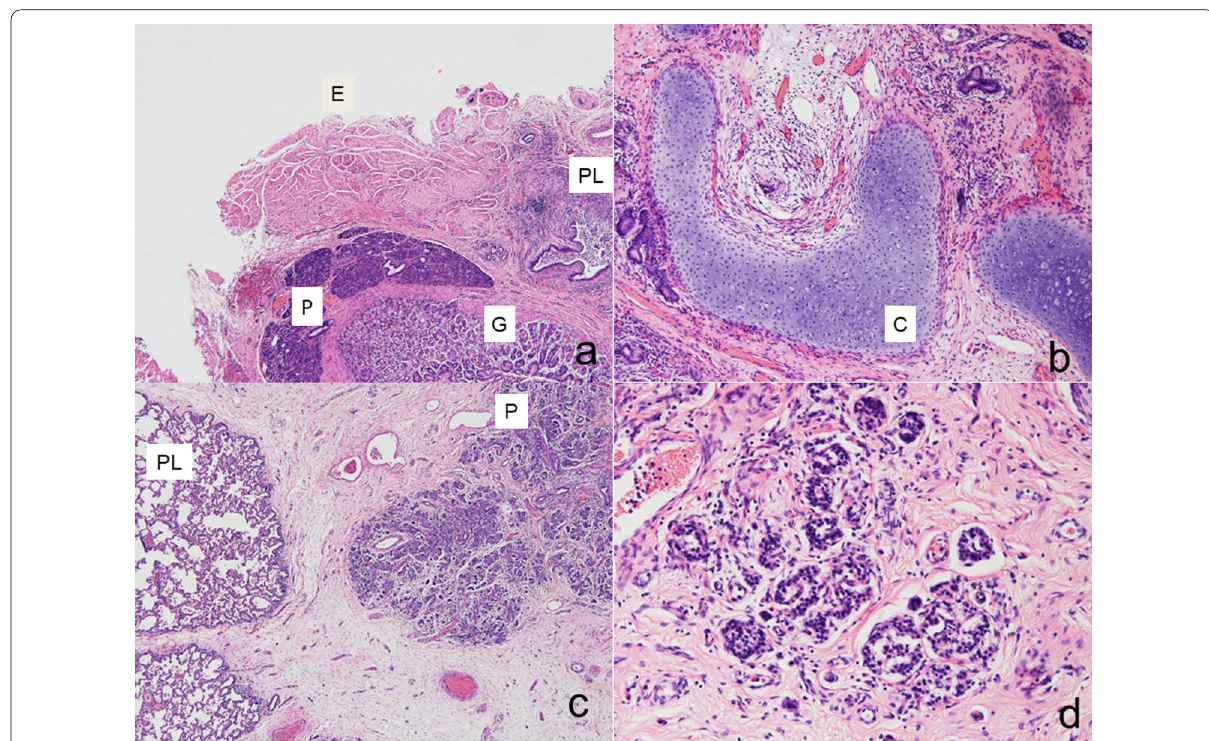
Fig. 4 Pathological findings. Histologically, the mediastinal surface of the sequestration was mostly composed of pancreatic tissue (P). Esophageal (E) and gastric (G) tissue, cartilage tissue (C) and ciliated epithelium were confirmed in pulmonary tissue (PL) ( a :